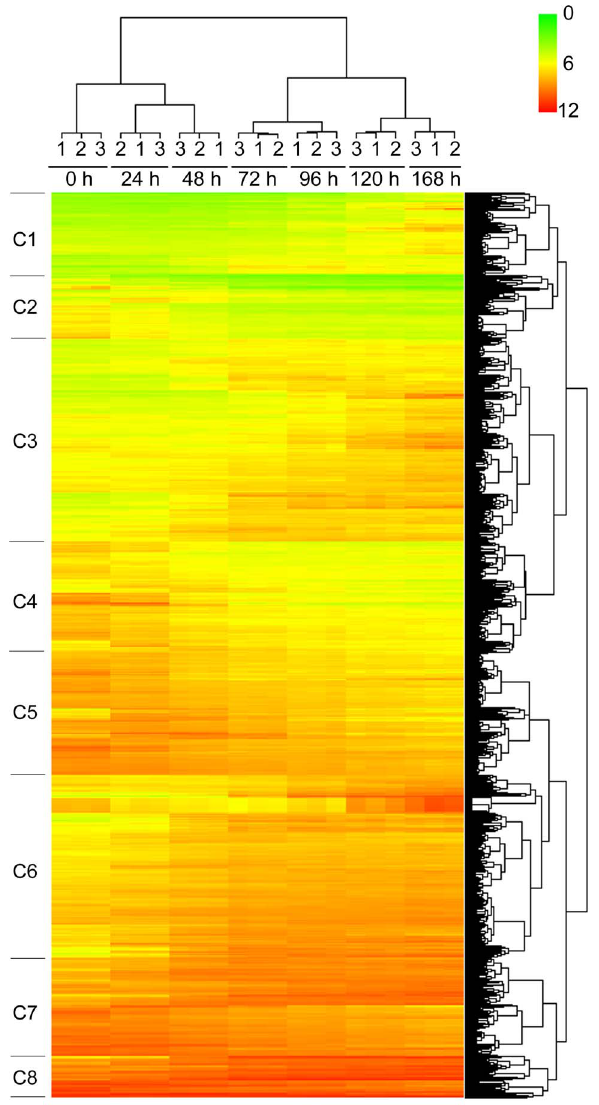
Figure 3. Hierarchical clustering of the 1996 DEGs. Each row represents a probe set and each column represents a sample. The expression data are presented as log 2 values with color schemes shown on the top-right corner. Broadly eight clusters were identified (C1 to C8) each with a distinct gene expression profile in terms of their expression dynamics with